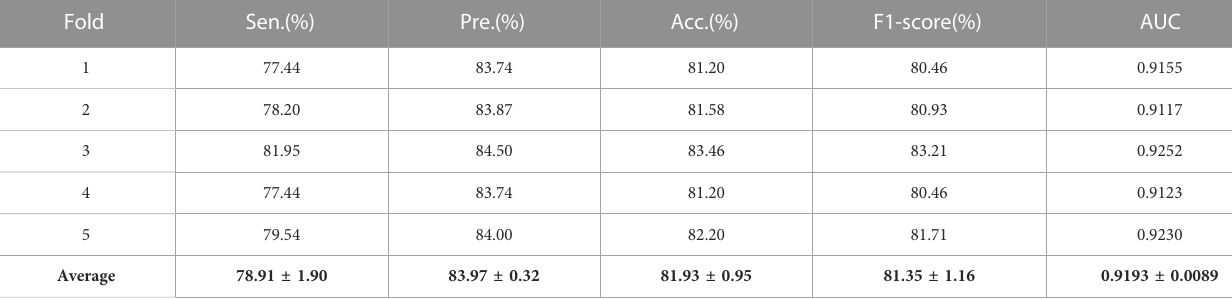
TABLE 3 The average sensitivity, precision, accuracy and F1-Score obtained by GNMFDMA. Fold